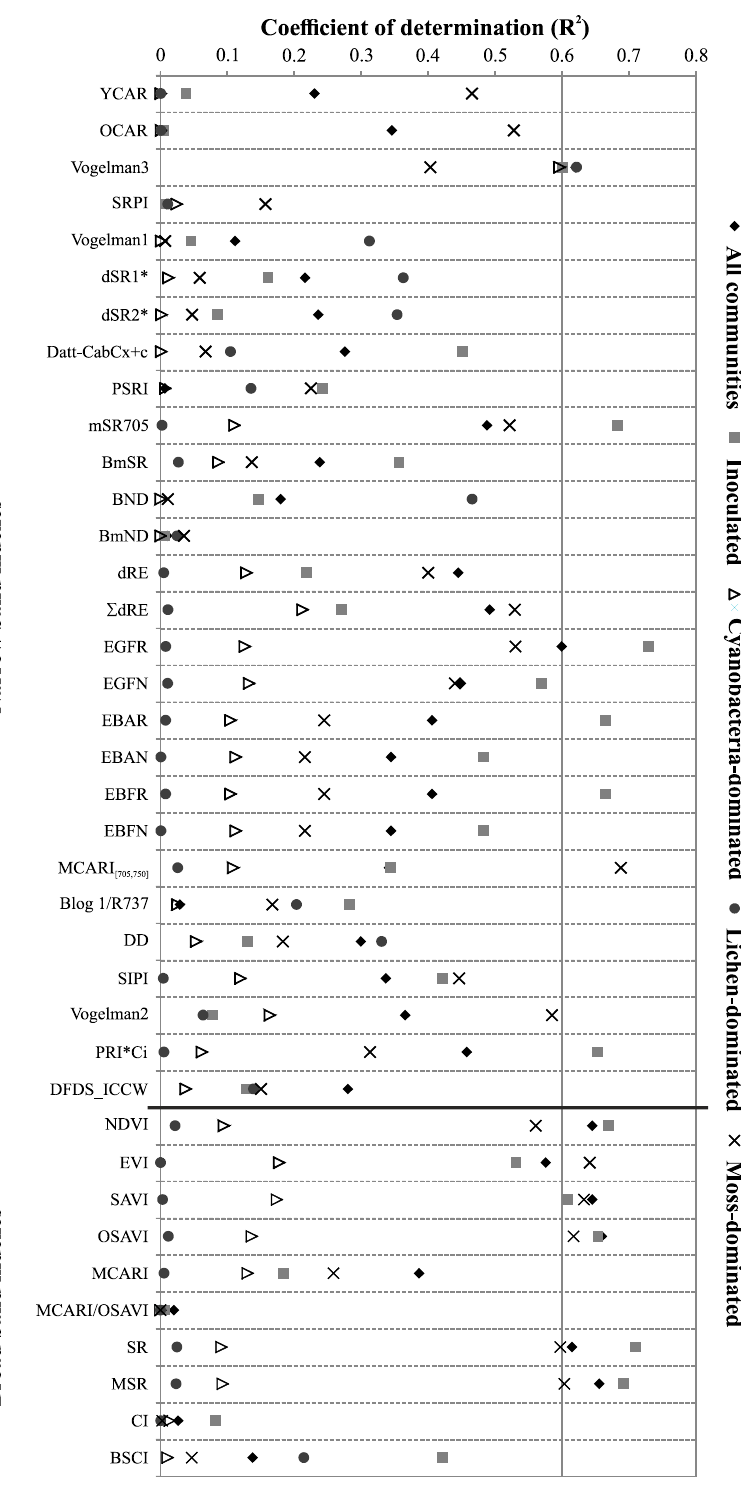
Figure 8. Coefficient of determination (R 2 ) between the chlorophyll a concentration and the standard vegetation indexes for each biocrust type.